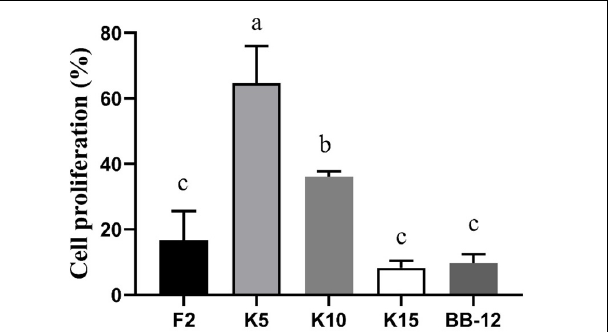
FIGURE 7 | CCD 841 CoN cells proliferation of the selected B. longum subsp. longum strains. P < 0.05 was considered to demonstrate statistically significant differences and recorded with different